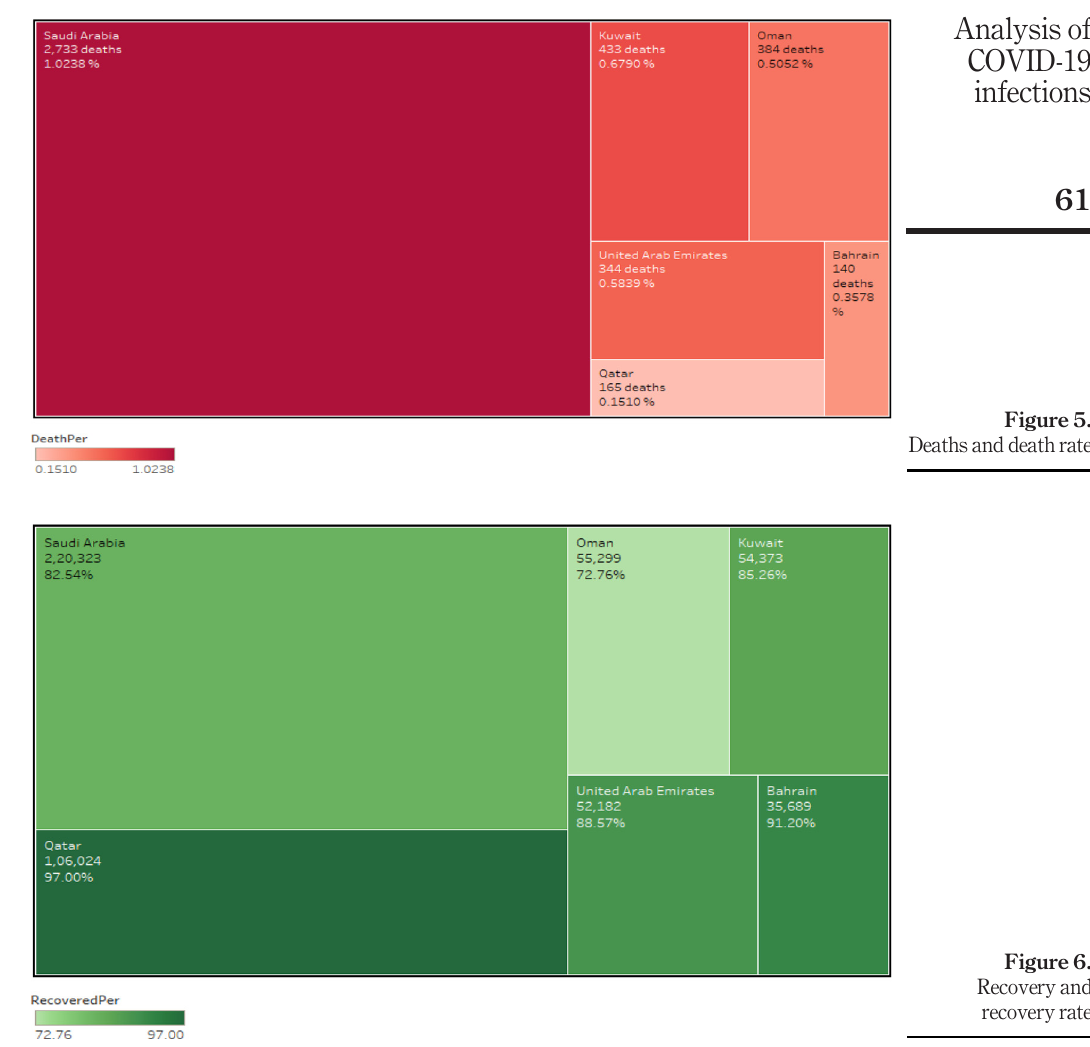
Figure 6. Recovery and recovery